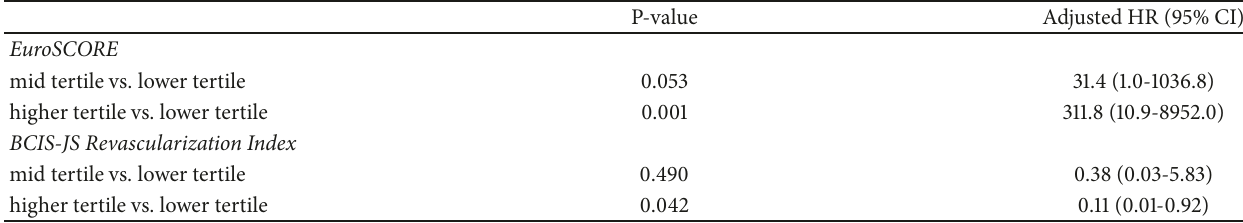
Table 5: Multivariate analysis for independent predictors of